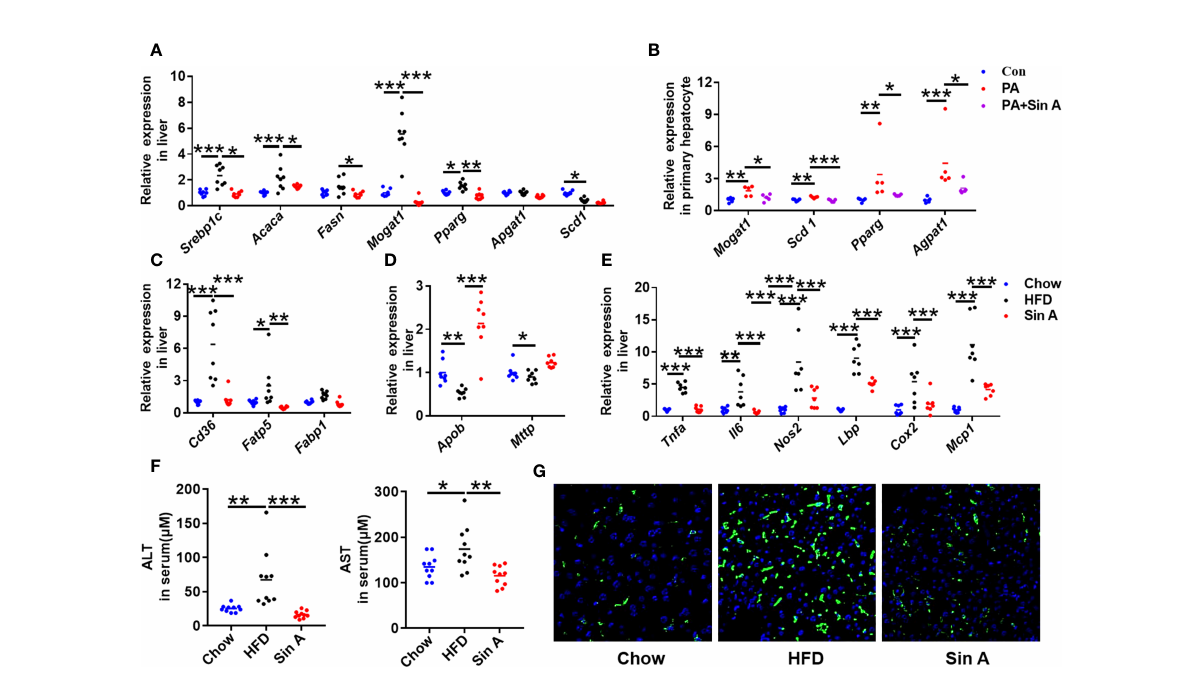
FIGURE 2 Sin A attenuates hepatic lipid accumulation and in fl ammatory response in NAFLD mice. Chow-fed mice were treated daily with normal diet (Chow). HFD-fed mice were orally treated with vehicle (HFD) or Sin A (80 mg/kg, Sin A) for 6 weeks. (A) The key gene expression associated with fatty acid biogenesis in liver. (B) Fatty acid biogenesis-related genes in primary hepatocytes with palmitic acid or Sin A incubation for 24 h ( n =5 per group). The gene expression associated with fatty acid uptake (C) and LDL-C export (D) in liver sections. (E) The expression levels of in fl ammation response-related genes in liver ( n =6 per group). (F) Changes in serum chemistry (ALT and AST) of mice ( n =10 per group). (G) The representative images of F4/80 staining in the liver (Scale bars 100 m m). Values are expressed as means ± SD. Statistical signi fi cance were determined by one-way ANOVA for the multiple-group comparisons. p *<0.05; ** p <0.01; *** p <0.001. Srebp-1c, sterol regulatory element binding protein-1c; Acaca, acetyl-CoA carboxylases alpha; Fasn, fatty acid synthase; Mogat1, Monoacylglycerol O-acyltransferase 1;